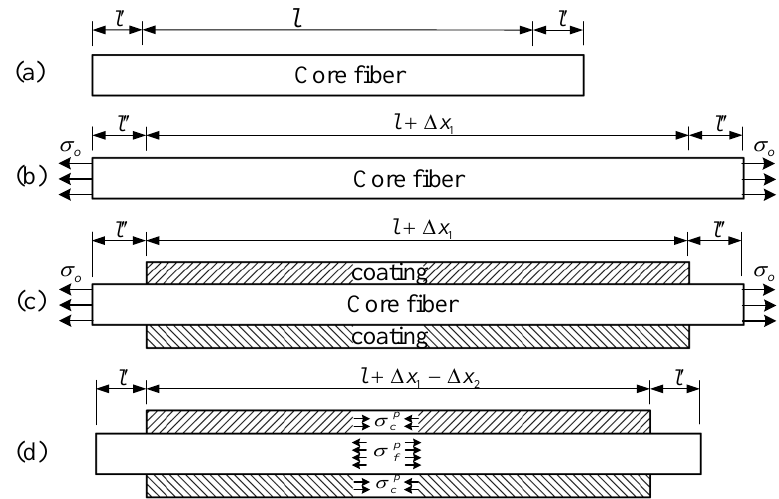
Figure 4. The process diagram of CIF force equilibrium, ( a ) unstressed stage, ( b ) pre-tension stage, ( c ) coating stage, ( d ) external force withdrawal stage.